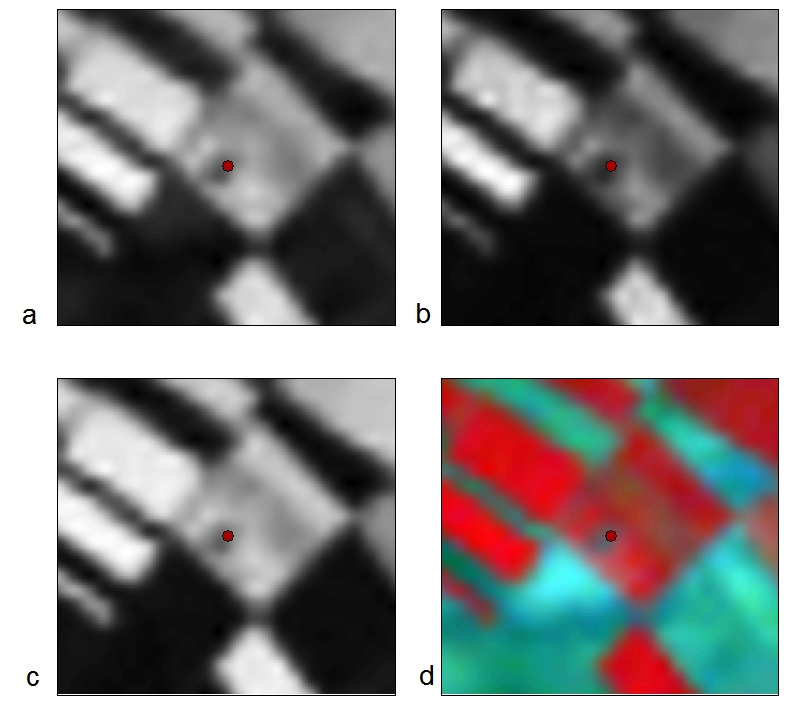
Figure 8. Landsat multispectral images used for the detection of the neolithic tell Melia 2 (indicated with a red spot) at the Thessalian plain, after the application of broadband indices: ( a ) SARVI, ( b ) Simple Ratio, ( c ) NDVI and ( d ) pseudo-color